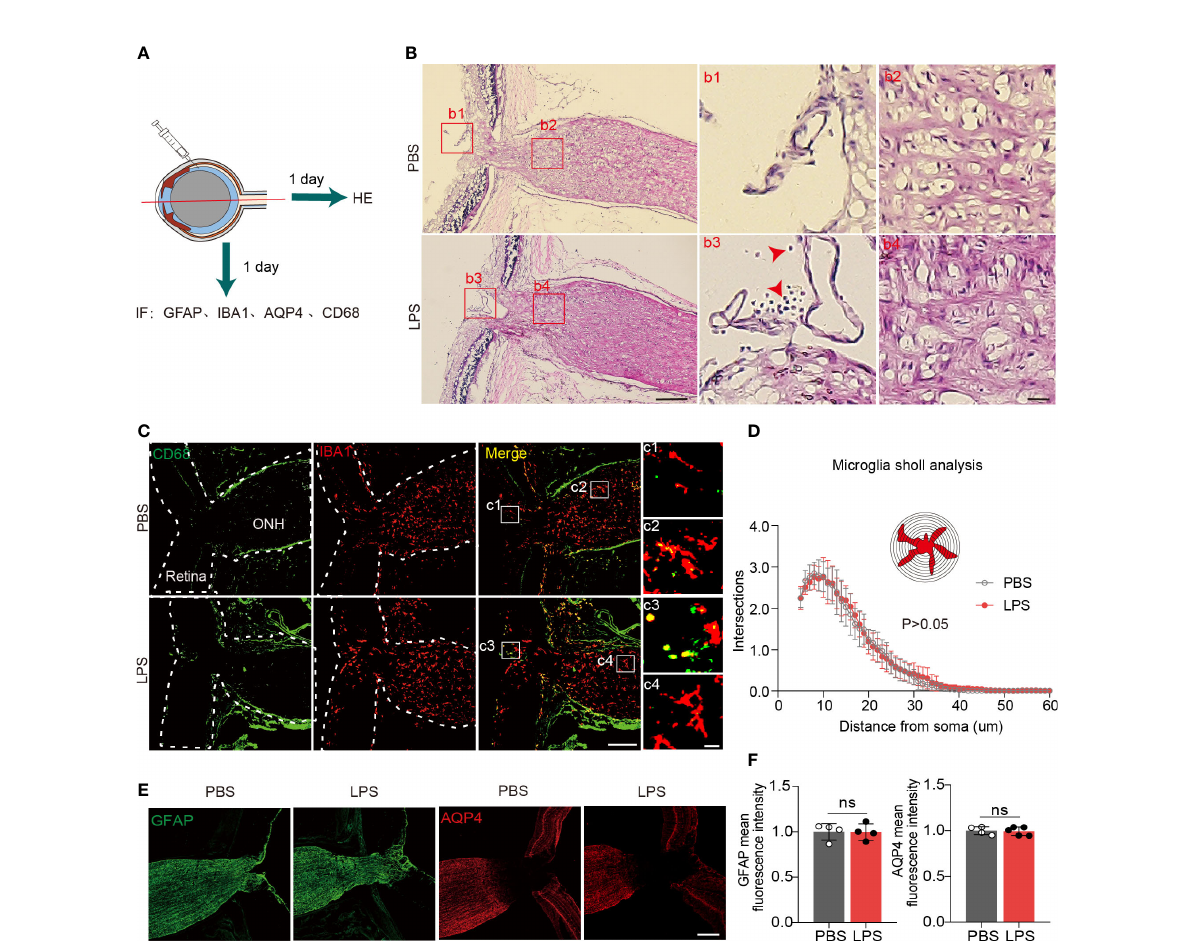
FIGURE 3 In fl ammatory cell in fi ltration and microglial activation in the ONH are not present on day 1 PII of LPS. (A) Diagram illustrating the experiments measuring in fl ammatory cell in fi ltration in the ONH on day 1 PII. Abbreviations: AQP4, aquaporin 4; CD68, also called macrosialin. (B) Representative images of hematoxylin and eosin (H&E) staining in the sagittal sections including the retina, ONH and ON on day 1 PII of PBS or LPS. Red square boxes are zoomed and displayed on the right. Regions b1 and b3 from the vitreous cavity, and regions b2 and b4 from the area of the ONH. Red arrows indicate in fl ammatory cells stained by H&E. Scale bar, 200 m m for the zoom-out view, 20 m m for the inserts of b1-b4, n = 7 ONs per group. (C) Representative images of immuno fl uorescence staining for CD68 and IBA1 in sagittal sections covering the partial retina and ONH. Regions c1 and c3 from the area of the vitreous cavity, and regions c2 and c4 from the area of the ONH. Scale bar, 200 m m for the zoom-out view (left), 20 m m for the inserts of c1-c4; n = 7 ONHs per group. (D) Sholl plot based on IBA1 immuno fl uorescence staining in the ONH. n = 7 ONH per group. (E) Representative images of immuno fl uorescence staining for GFAP and AQP4 in sagittal sections covering the partial retina, ONH and partial ON for both groups. Scale bar, 100 m m. (F) Histograms summarizing the mean fl uorescence intensity of GFAP and AQP4 for both groups. Data are normalized to the average of the PBS groups. n = 4-5 ONs per group. Unpaired t test or two-way repeated measures ANOVA was performed for statistical analysis, ns, non-signi fi cant, P >